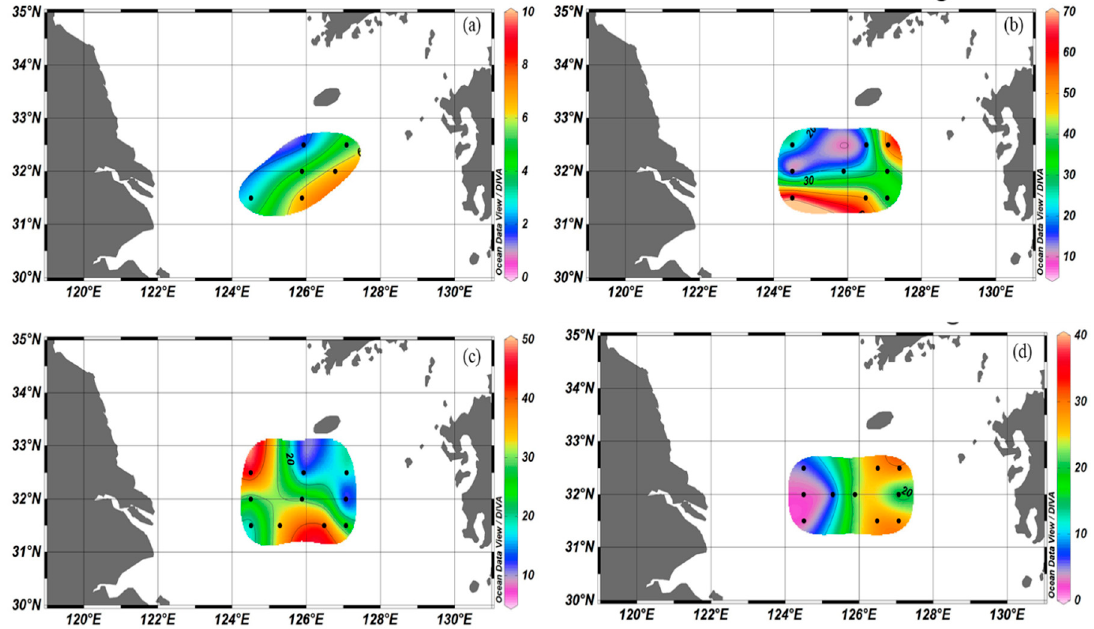
Figure 3. Horizontal distributions of water column-integrated chlorophyll-a concentration from surface to 1% light depth in the northern East China Sea ( a ) February, ( b ) May, ( c ) August, and ( d ) November.